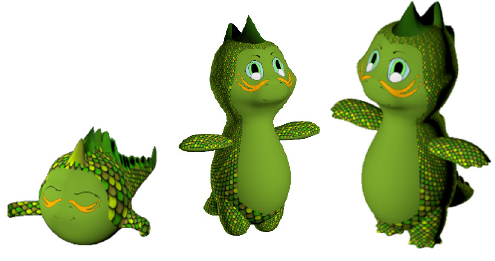
Fig. 2. “Phiby” in different states of development. Left: Pollywog. Center: Toddler. Right: Infant. In each state, his physique is developing a step further (growing limbs, fingers etc.).